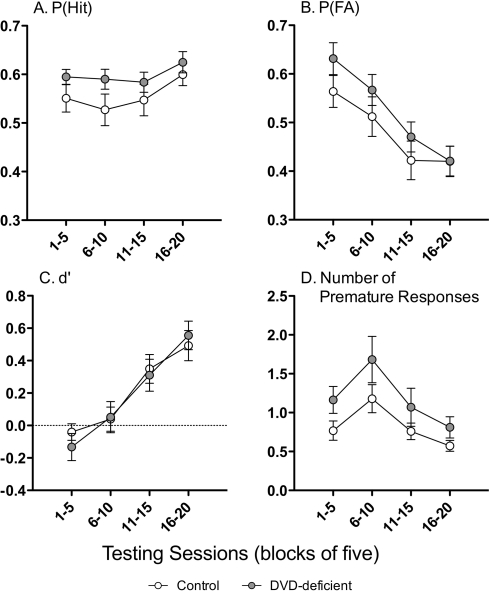
Performance of mice on the 5C-CPT.This figure shows the P(Hit) (A), the P(FA) (B), the discrimination index d′ (C) and premature responses (D) for control (n = 19) and DVD-deficient (n = 19) mice averaged over 4 blocks of 5 trials. DVD-deficient mice also made more premature responses than control mice, although this did not reach significance (Main effect of Diet F
1,34 = 3.66, P = 0.064). Data are expressed as mean ± SEM. * P<0.05 and τ P<0.1 between control and DVD-deficient mice.